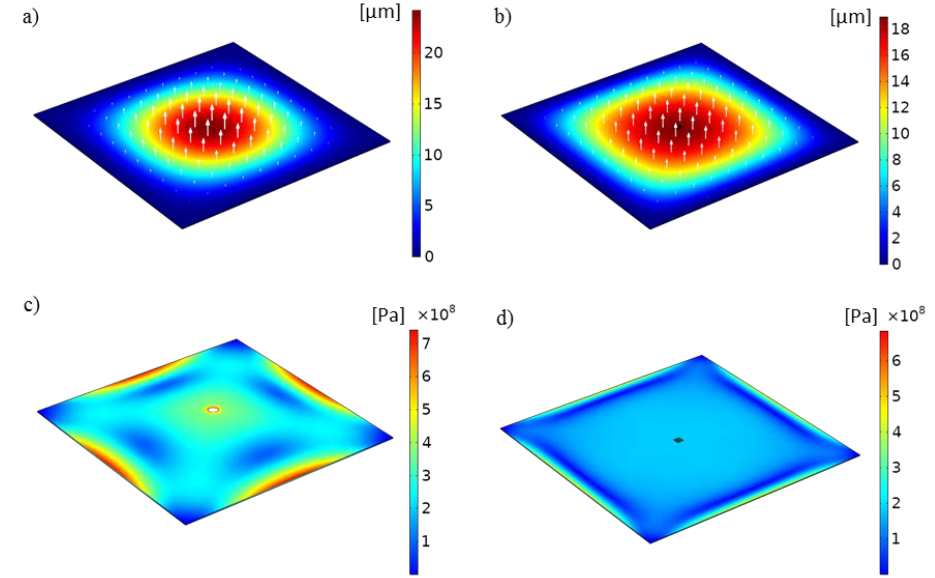
Figure 4. Simulation results of linear and nonlinear models. Membrane deflection under an applied pressure of 20 psi for ( a ) the linear model and ( b ) the nonlinear model. The apertures are shown in the insets within yellow dashed boxes in both cases. Stress distribution (von Mises yield criterion) under an applied pressure of 20 psi for ( c ) the linear model and ( d ) the nonlinear model.